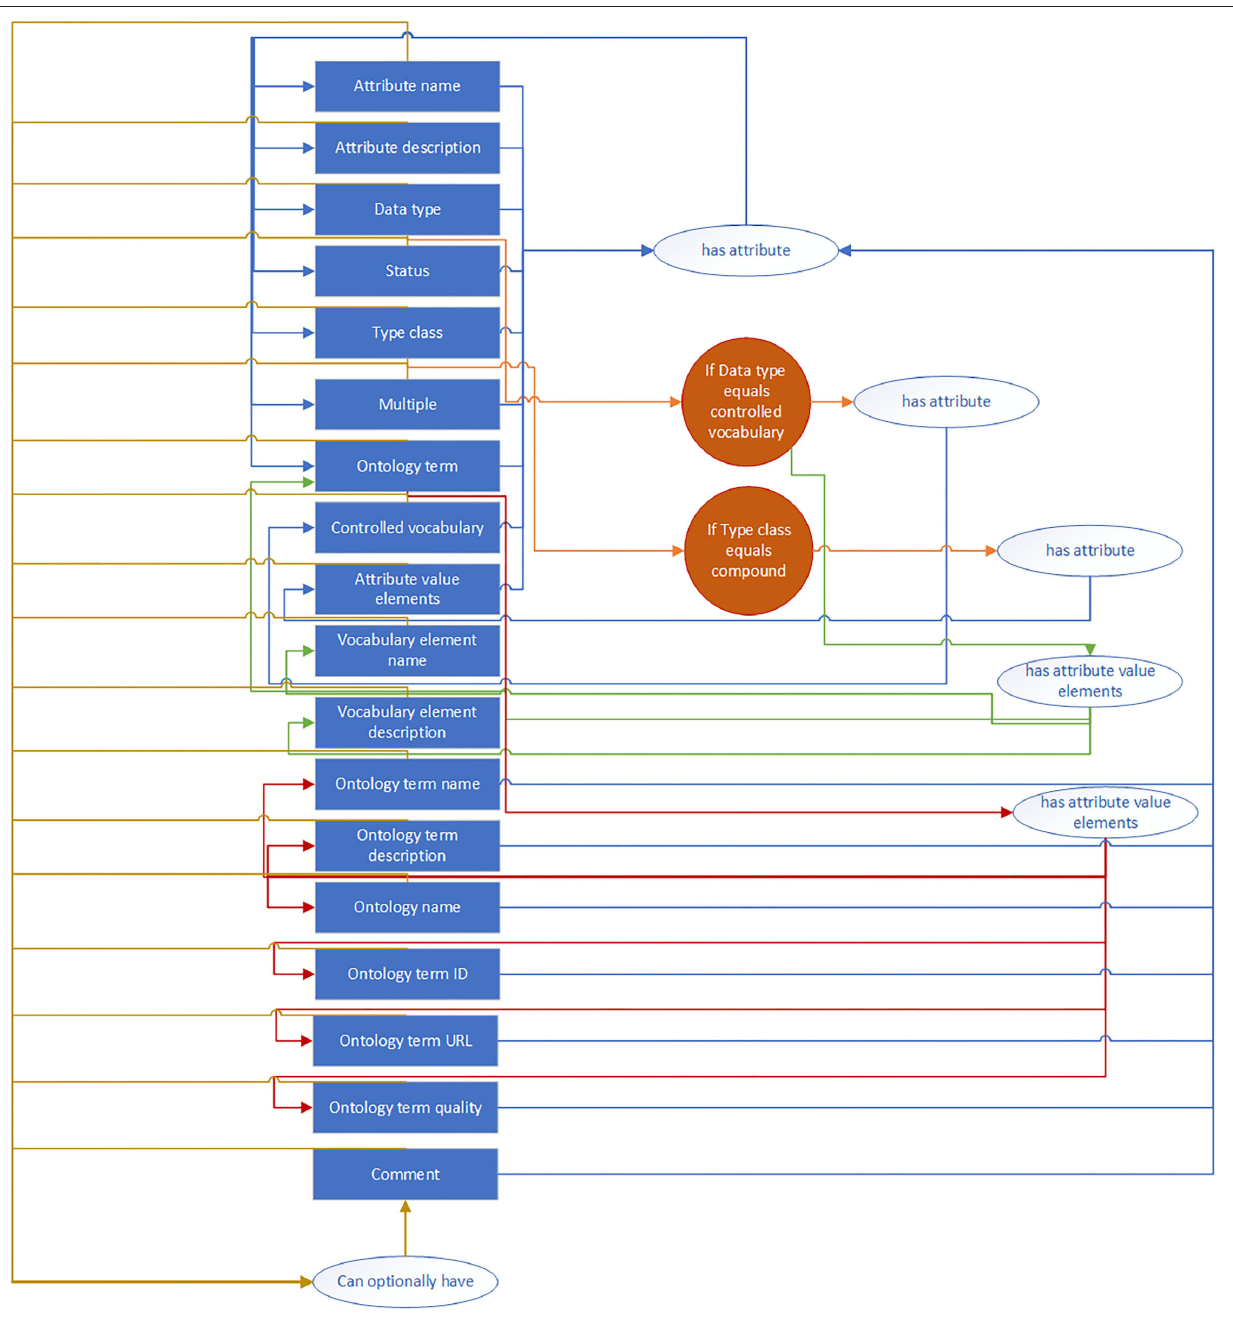
FIGURE 2 | Diagram of the self-describing metadata